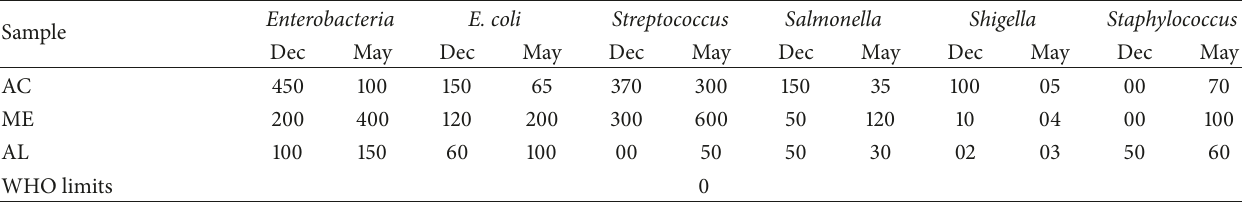
Table 5: Results of bacteriological analysis (specific microbes identified per colony forming unit, CFU/100mL).